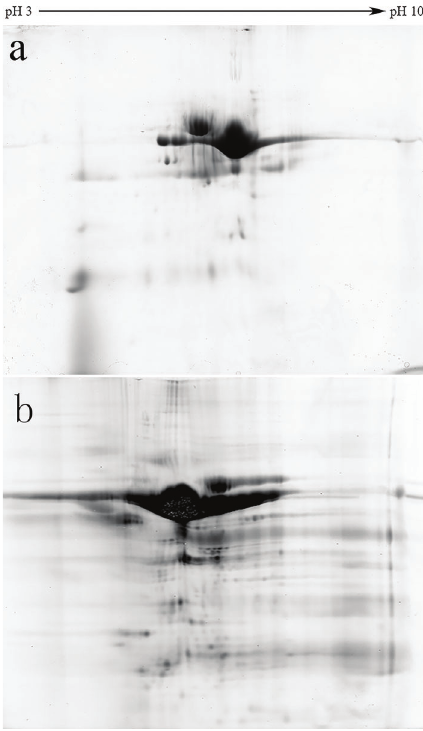
Figure 3. a , Seven-centimeter Coomassie blue-stained 2-DE gel of crude antigen of EgCF; b , Twenty-four-centimeters fl uores- cence scanning 2-DE gel of crude antigen of EgCF. 2-DE, two- dimensional gel electrophoresis; EgCF, Echinococcus granulosus cyst fl